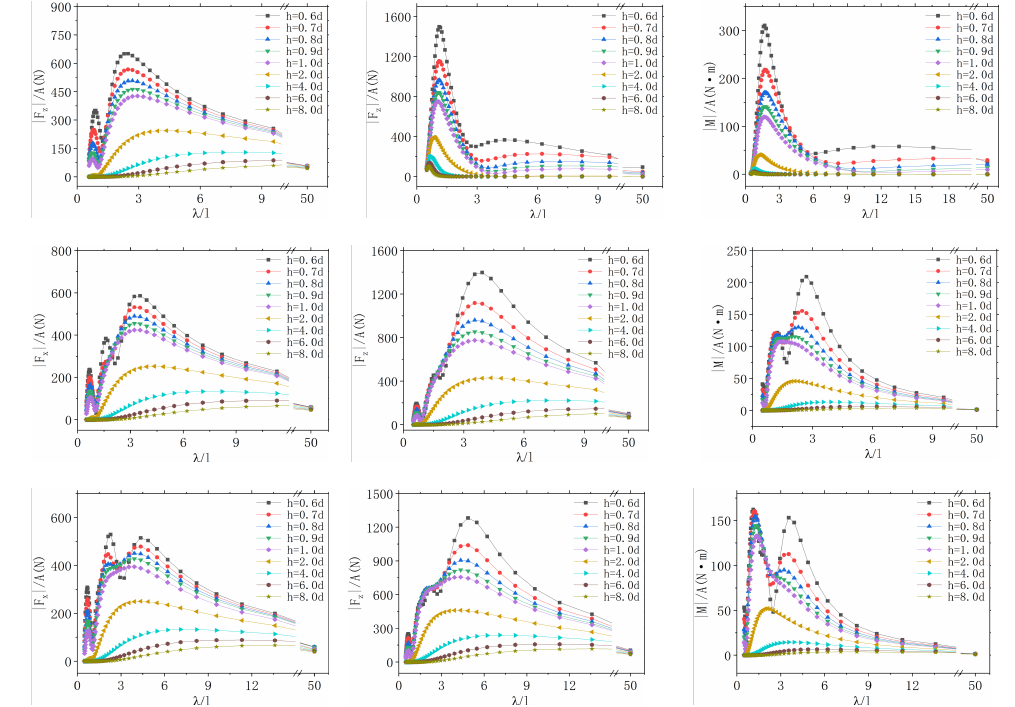
Figure 14. Curves of wave force versus velocity of the Shark-AUV at different submerged depths. From the left column to the right column are the longitudinal force, vertical force and pitch moment of the AUV at the speeds of 0 m/s, 0.5 m/s and 1